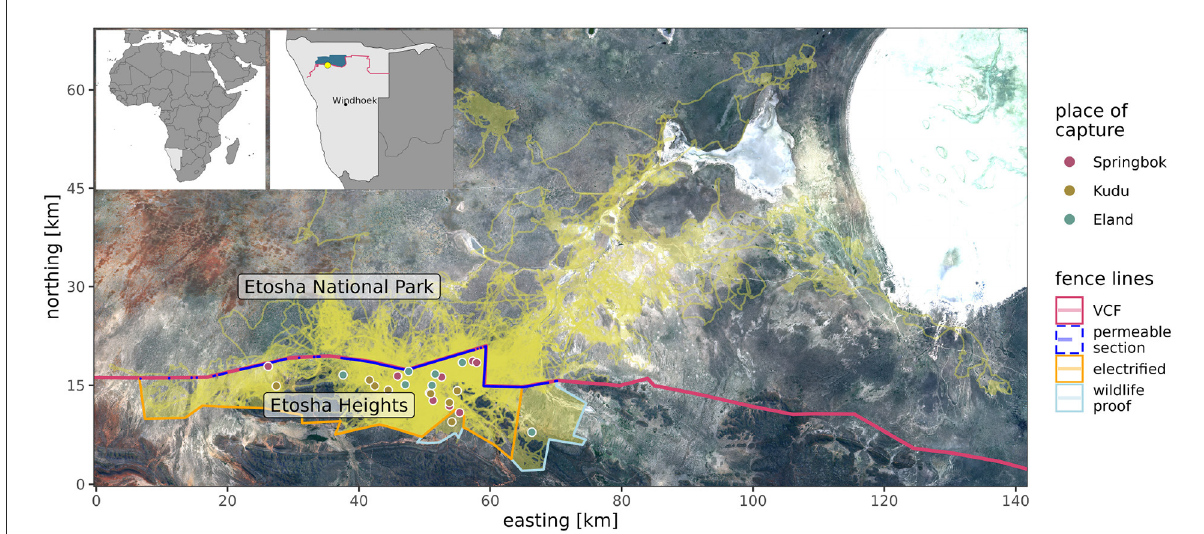
FIGURE1 Study area with focal fence lines, identified parts where crossings occurred (permeable section) and locations of animal capturing (see legend) and movement trajectories (in light yellow). Background Sentinel 2 (Bands 3,4,5) image, March 2020 (Contains modified Copernicus Sentinel data [2020]). Upper left maps show location in Africa and Namibia. Namibia map shows veterinary cordon fence (VCF, red line) and focal wildlife conservation areas